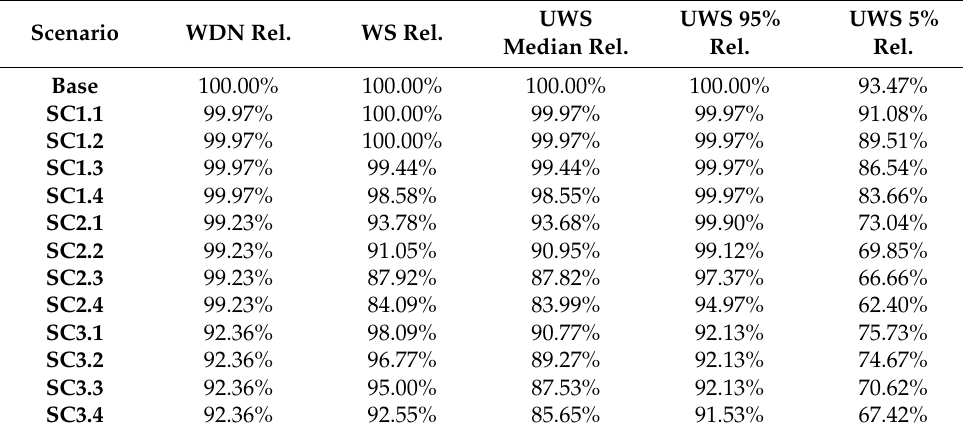
Table 2. Scenario analysis for Configuration